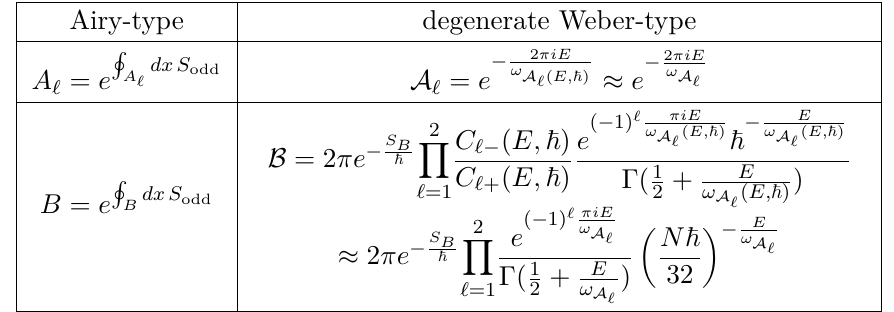
Table 1 . Dictionary of A and B cycles between the Airy-type and the DW type. The quantum frequency ω ( E, ~ ) has the relationship with F ( E, ~ ) in eq. (4.4) as ω A p 2 ω A + O ( ~ ) . Furthermore, S B = 2 R a 2 V ( x ) dx ∈ R > 0 is the classical bion action. For the periodic a 1 potential, all of A -cycles are